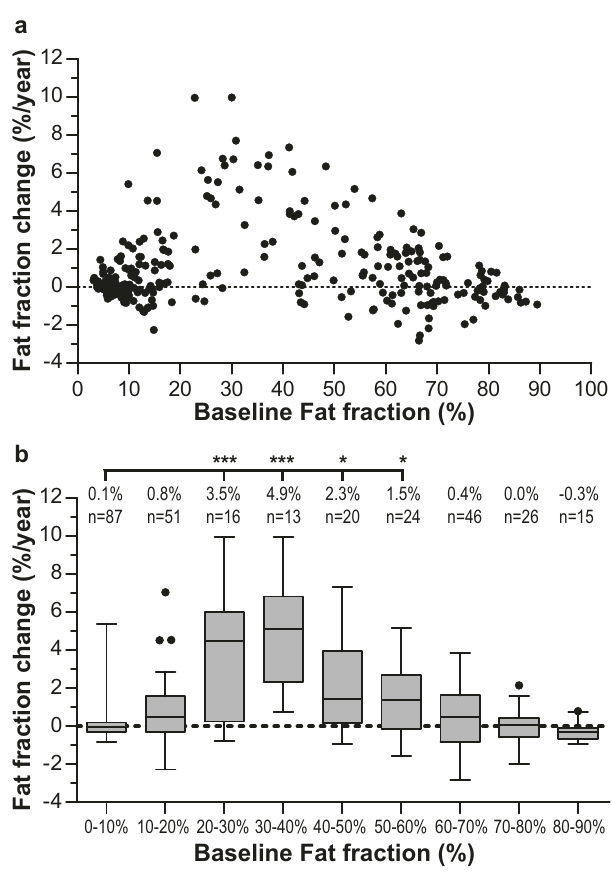
Fig. 3 Change in fat fraction per year of muscles in facioscapulohumeral muscular dystrophy (FSHD) patients. a Scatterplot of baseline fat fraction vs. change in fat fraction per year. Each dot represents one muscle. b Tukey boxplots (showing median, interquartile range, and outliers) per 10% baseline fat fraction group, indicating a faster progression in muscles with a baseline fat fraction between 20 – 60% compared with muscles with a baseline fat fraction of <10%. The mean values of fat fraction change and the number of analysed muscles ( n ) are displayed in the text above the boxes. * p < 0.05, *** p < fat fraction, where the error varied from − 11.8 to + 23.5%. However, when we selected fi ve slices equally spread over the whole muscle length, the average error was reduced to 0.1% with limits of agreement from − 1.5 to 1.7% (Fig. 7a). The estimated absolute error in the baseline fat fraction was reduced sevenfold, to only 0.6% (0.1; p < 0.001). With this approach, the error also becomes independent of the baseline fat fraction.